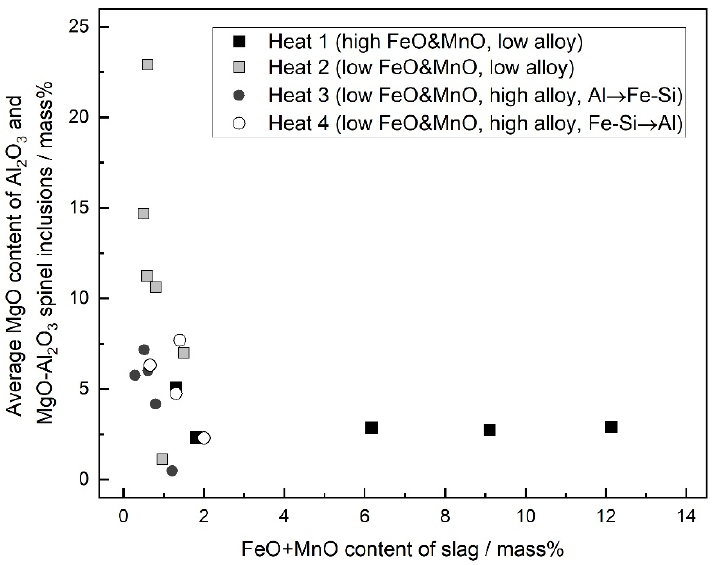
Figure 16. Effects of the FeO and MnO contents of the top slag on the MgO content of the observed inclusions.